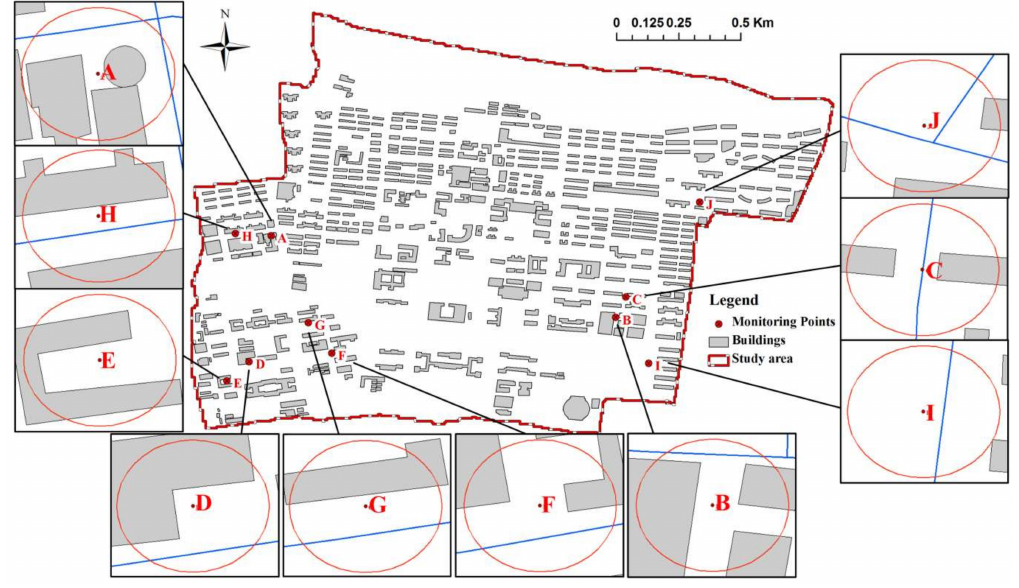
Figure 9. Geographic information of monitoring points in study area. Table 1. The observed data and BCR for each monitoring